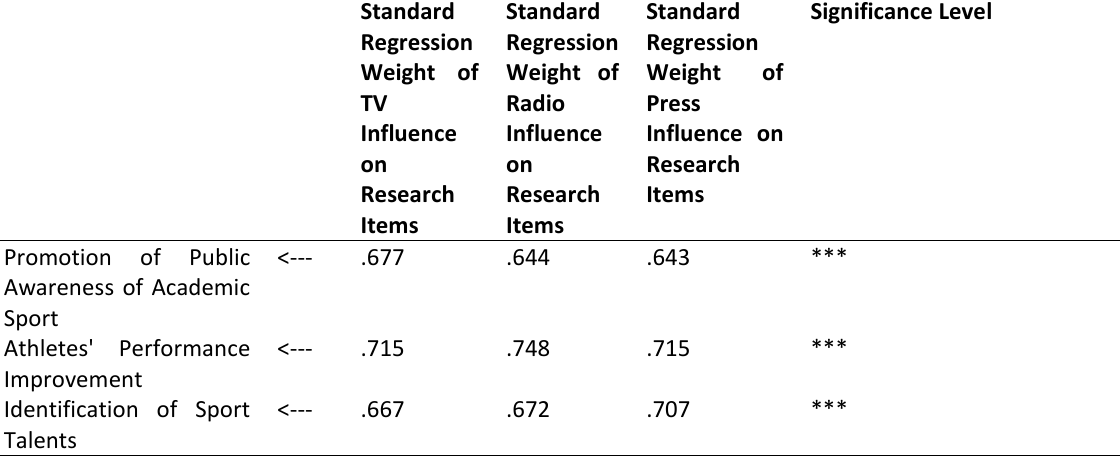
Table 3. Factor Analysis of Role of Television, Radio, and Press on Academic Sport Development